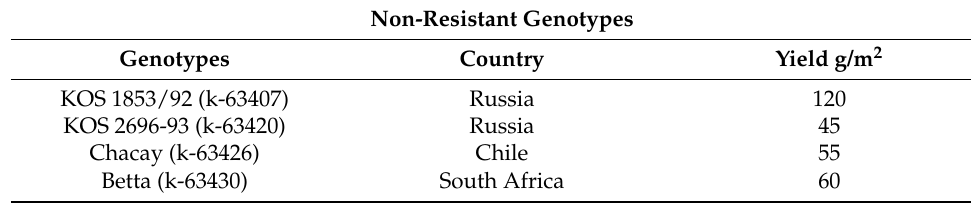
Table 8. Yield of the nonresistant genotypes (2002–2003).